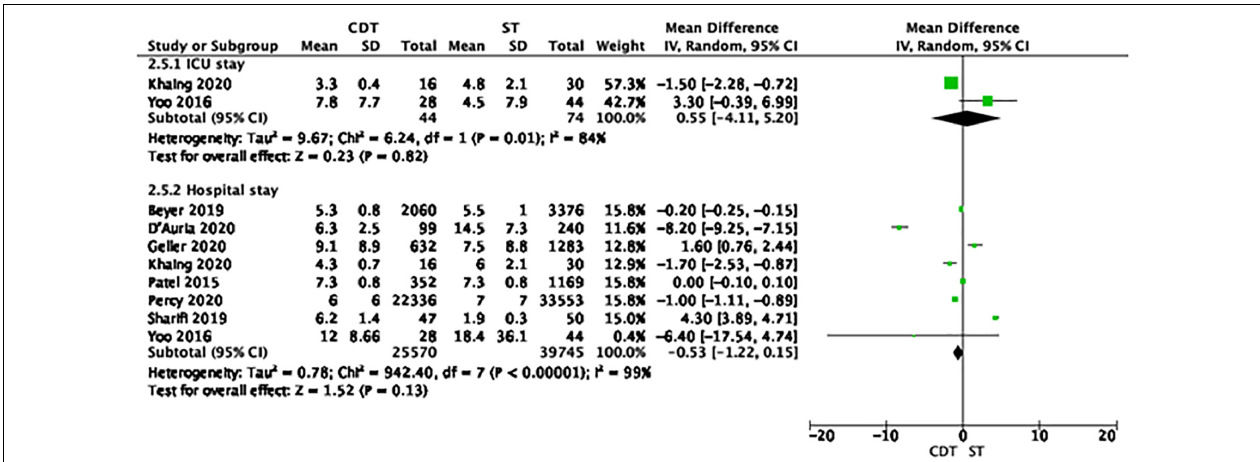
TABLE 2 | Primary and secondary outcomes in patients treated with catheter-directed therapies (CDT) and systemic thrombolysis (ST). Outcome No of Events/participants Events Heterogeneity studies CDT group